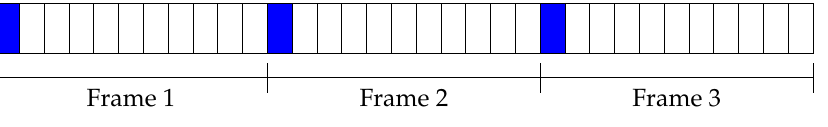
Figure 5. Example of Disco for p =